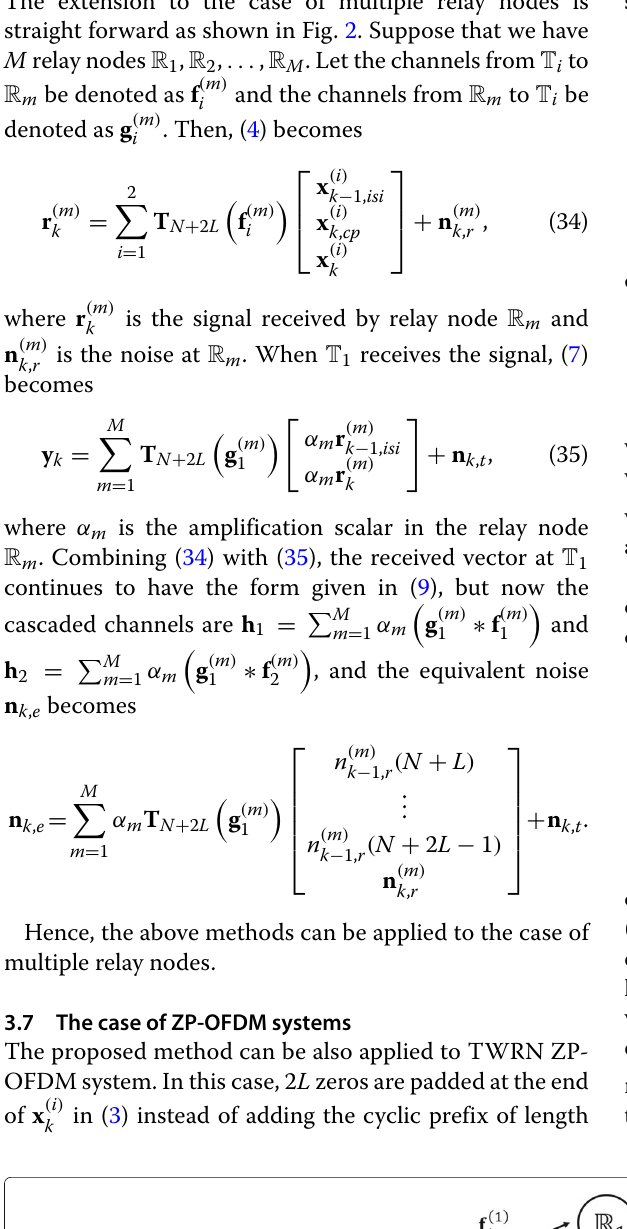
( m ) i and the channels from